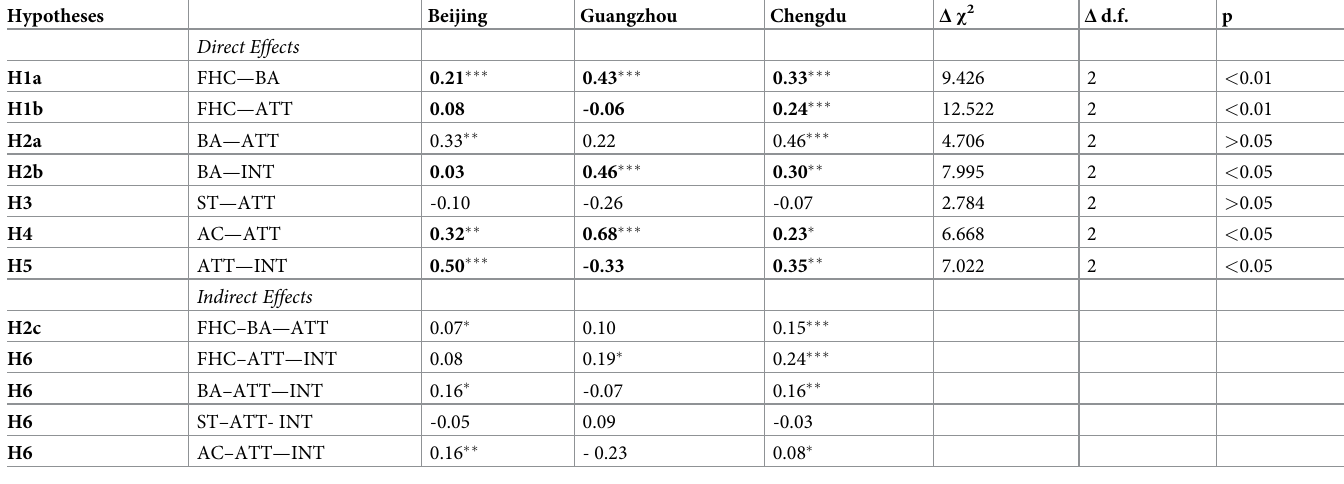
Table 7. Structural paths, multi-group analysis and structural